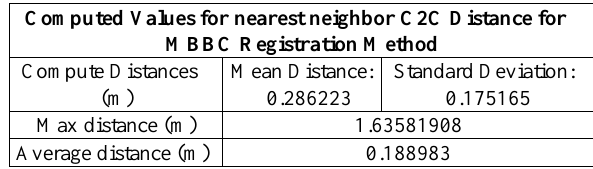
Table 6. Computed values for nearest neighbor C2C distance